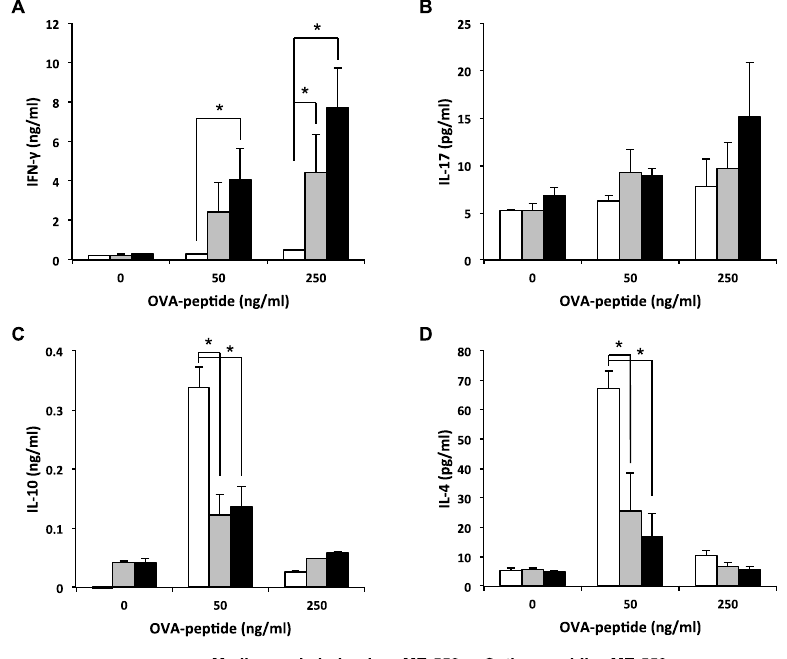
Figure 2. Effects of lactic acid bacteria on T cells response upon antigen-pulsed dendritic cells from spleen. Splenic CD11c + cells from wild-type mice were pulsed with OVA peptides (0, 50, 250 ng/mL) and co-cultured with splenic naïve CD4 + T cells from OT-II mice in the presence of heat-killed L.